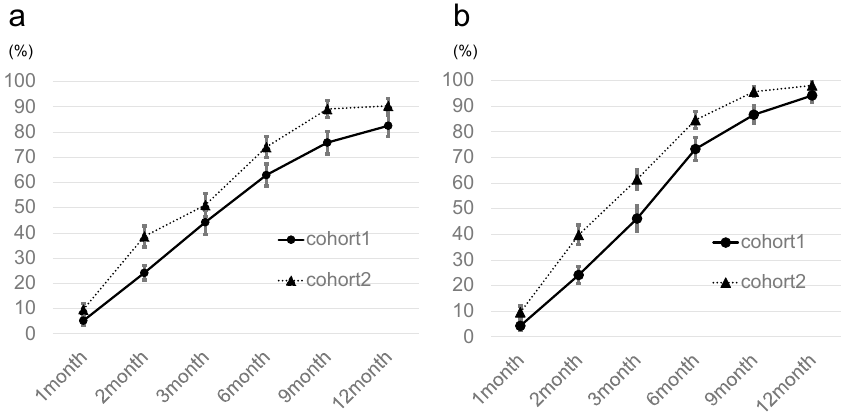
Figure 3. Results of evaluation with plain radiographs during the follow-up period. ( a ) The values of material resorption. ( b ) The values of trabeculation through the defect. The results are presented as the mean, and the bars indicate standard errors.